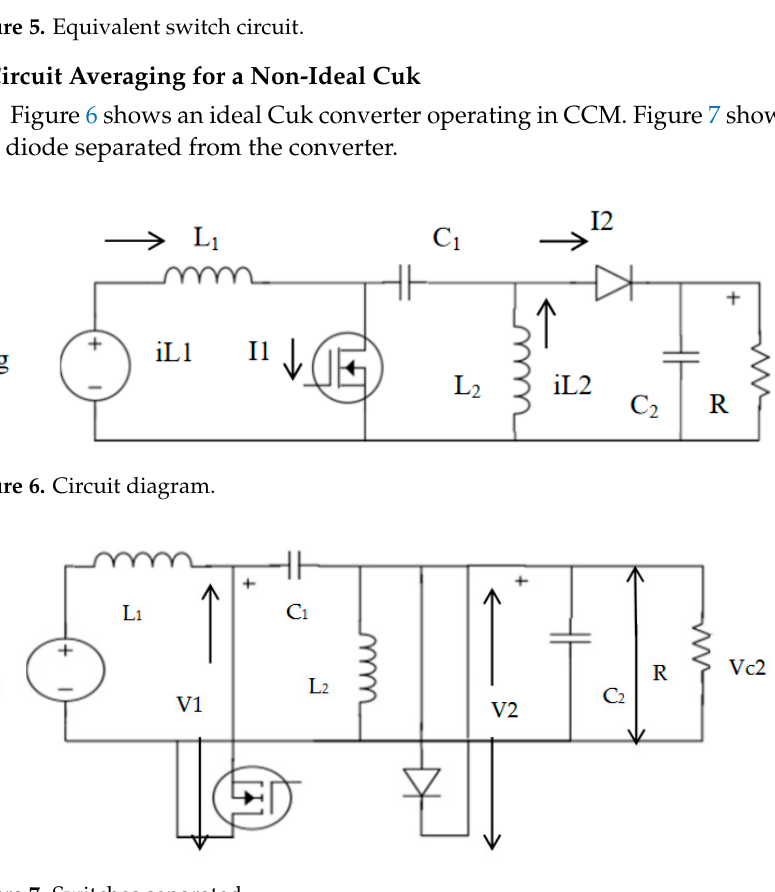
Figure 5. Equivalent switch circuit.